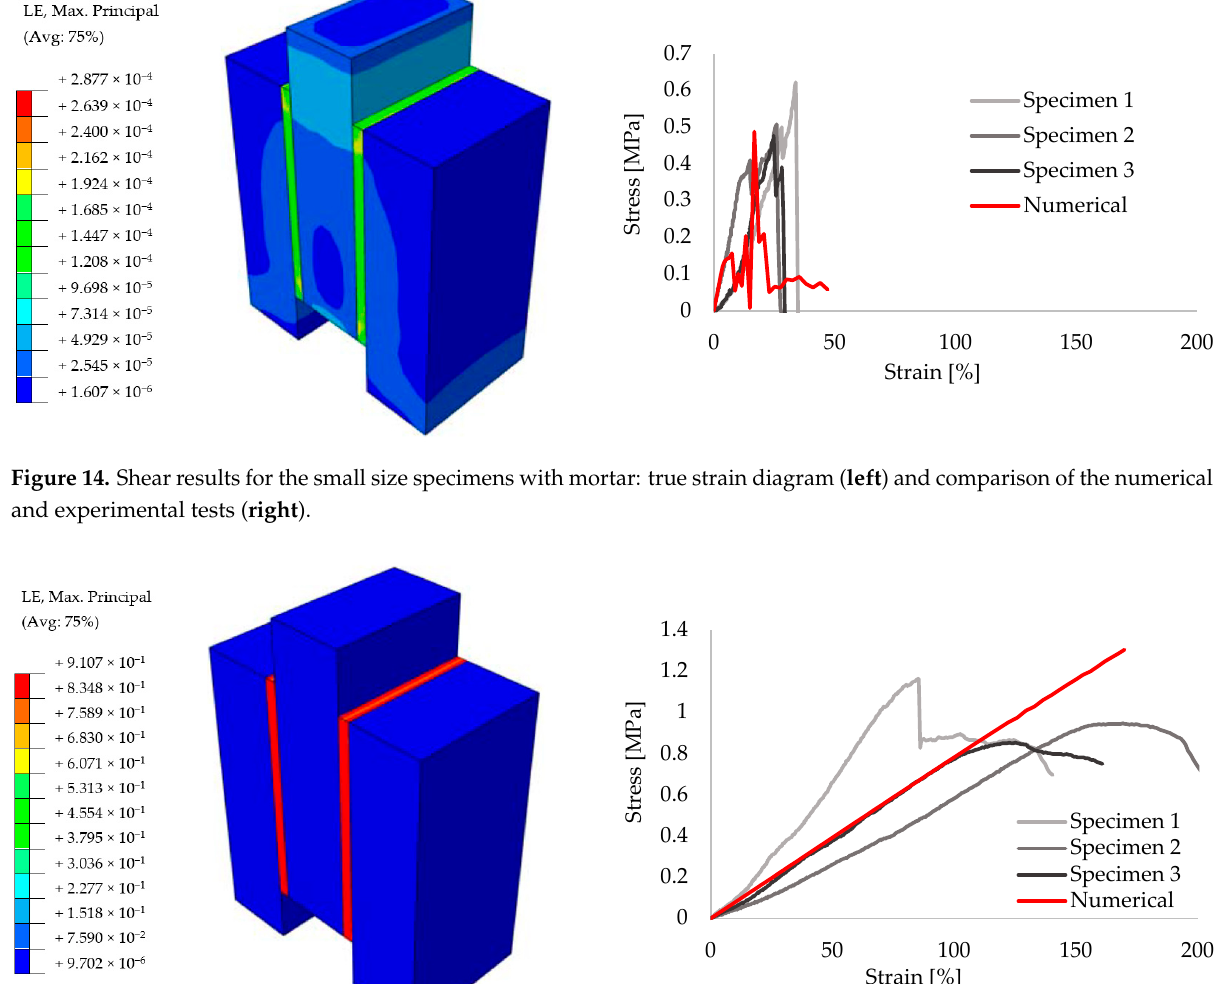
of the numerical and experimental tests ( right ).